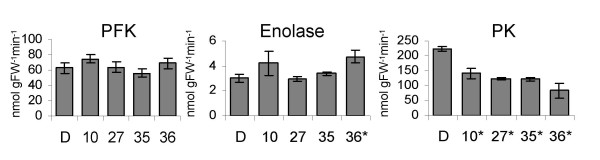
Glycolytic enzyme activities. Activities of the enzymes involved glycolysis in tubers of HD1 plants. Enzyme activities were measured in the same tuber's samples as the one used for carbohydrate, catecholamine and metabolite analysis. Data represent the mean ± SE of determination on three individual plants per line. Asterisks (*) indicate values that are significantly different from the wild type plants. PFK – phosphophructokinase; PK – pyruvate kinase.